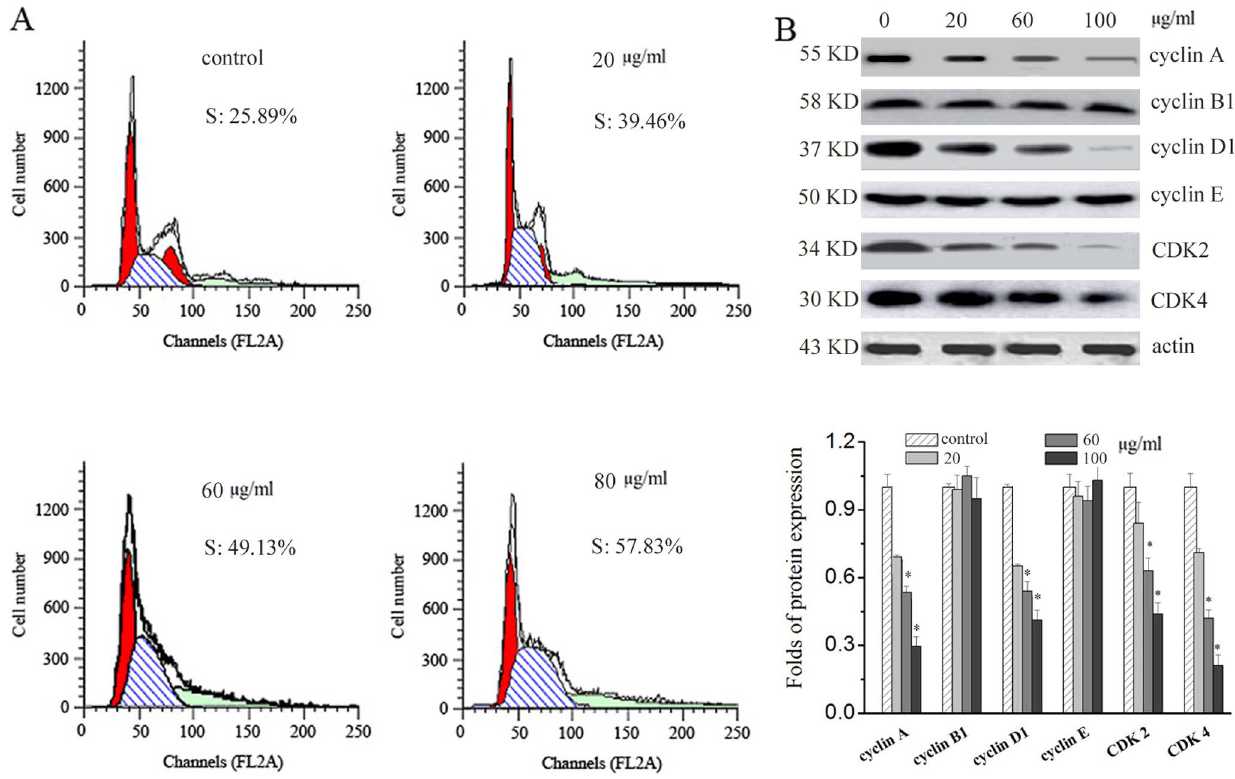
Figure 2. Effects of TCS on HeLa cell cycle progress and cell cycle regulatory proteins. HeLa cells were treated with indicated doses of TCS for 24 h. Cell number of S phase increased significantly (A) and expressions of cyclin A, D1 and CDK2, 4 significantly decreased (B). Data represent means 6 SD of three independent experiments (* p , 0.05 compared with control).